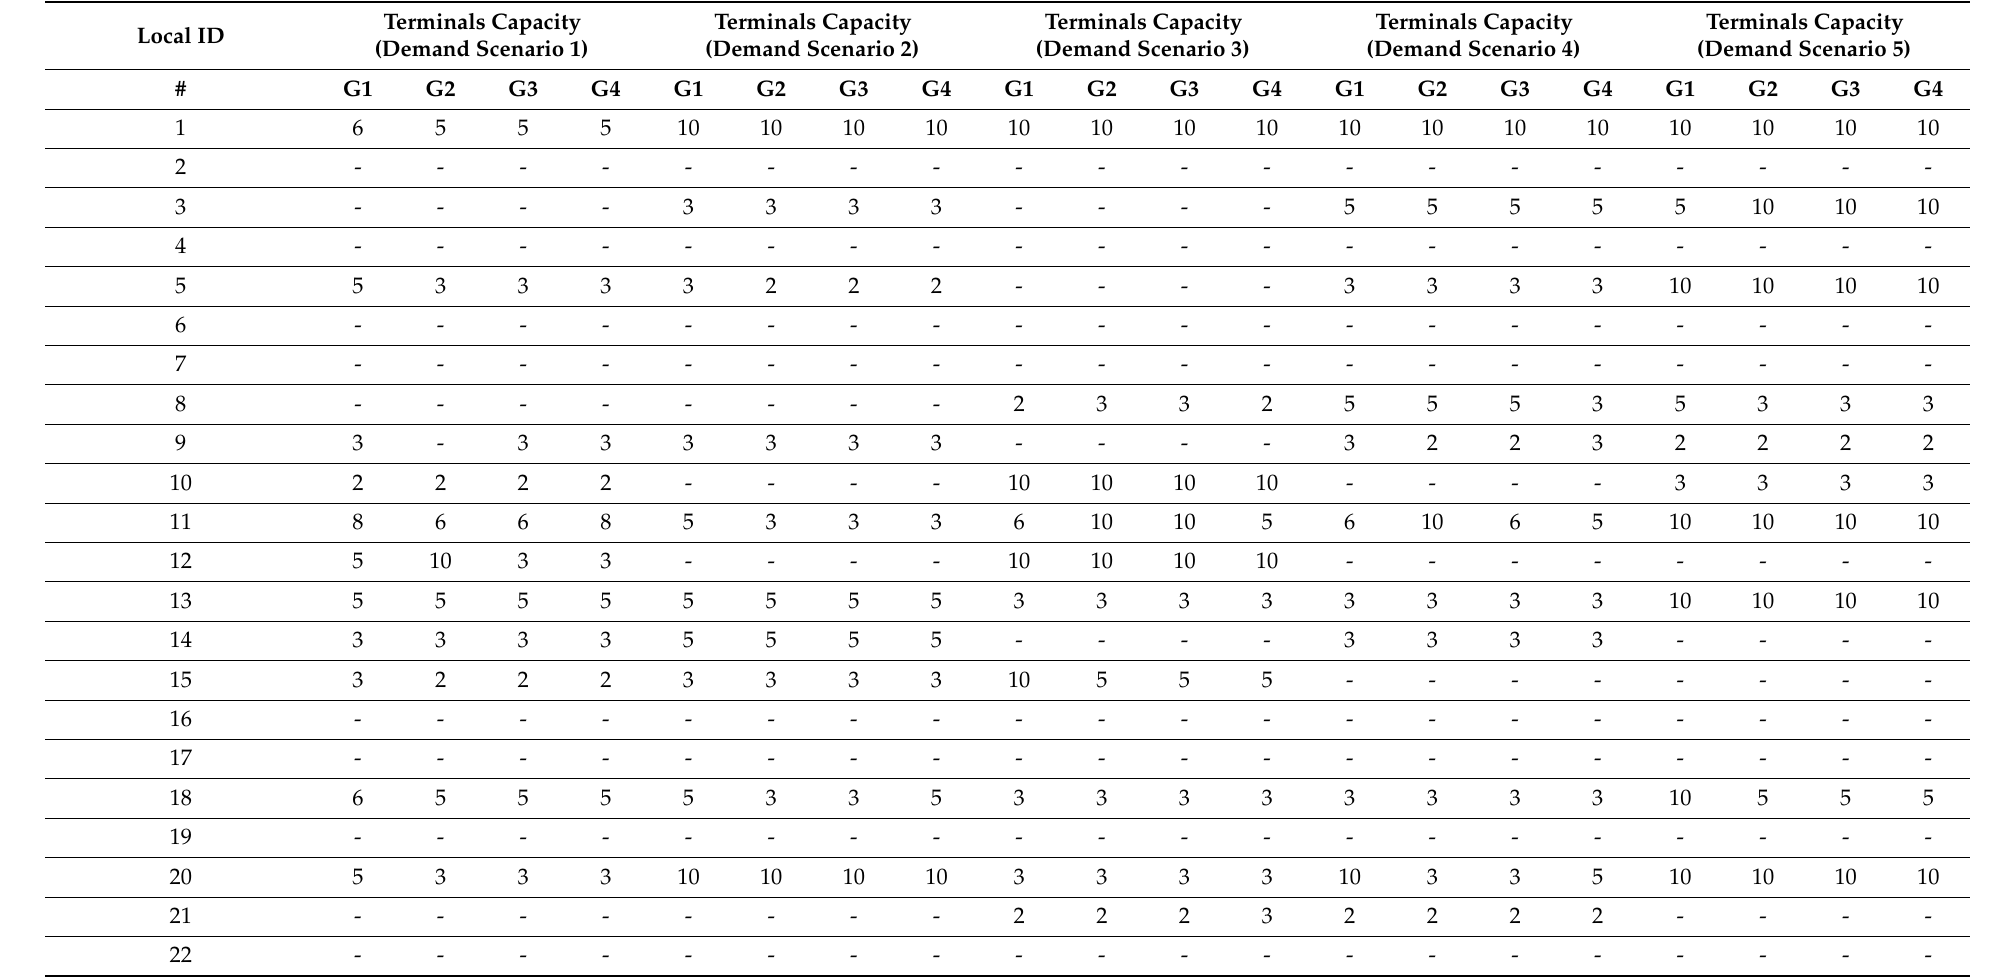
Table 12. Model results: locations and capacity of installed